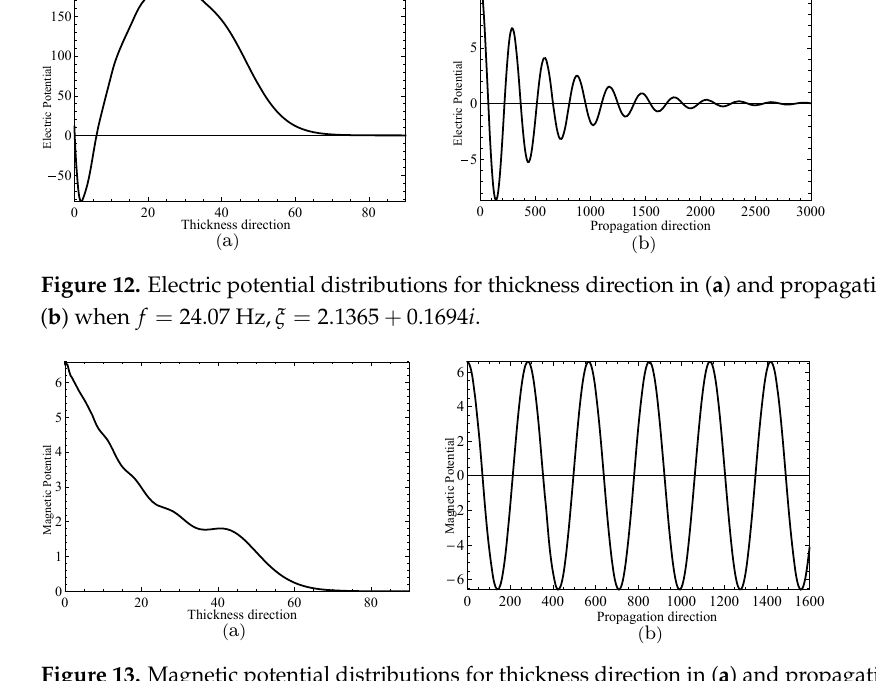
Figure 13. Magnetic potential distributions for thickness direction in ( a ) and propagation direction in ( b ) when f = 24.10 Hz, ξ = 2.2152.